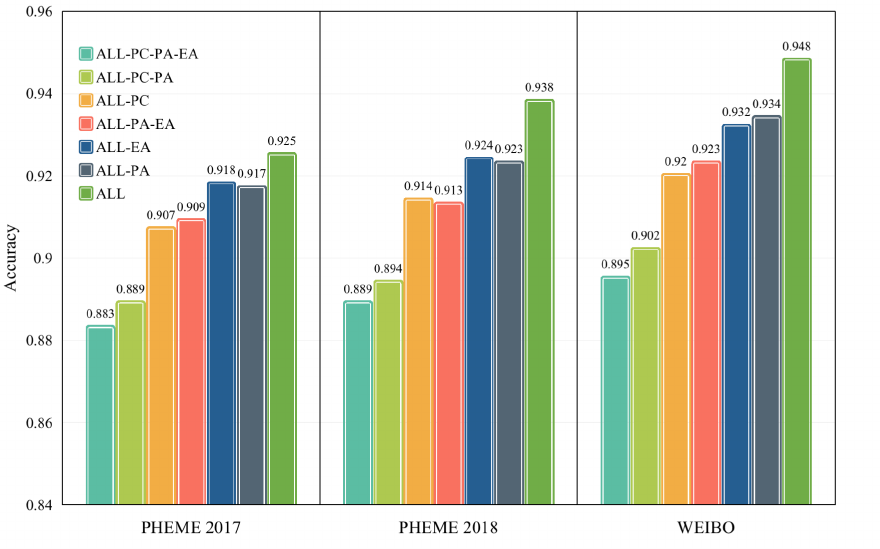
Figure 4. HAT4RD ablation analysis in